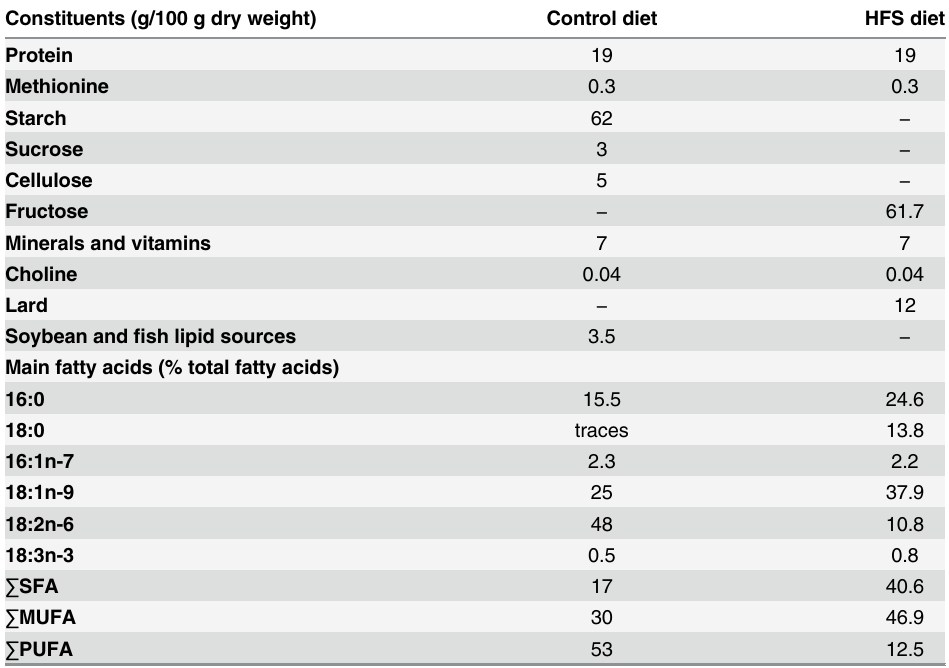
∑ SFA = total saturated fatty acids, ∑ MUFA = total monounsaturated fatty acids, ∑ PUFA = total polyunsaturated fatty